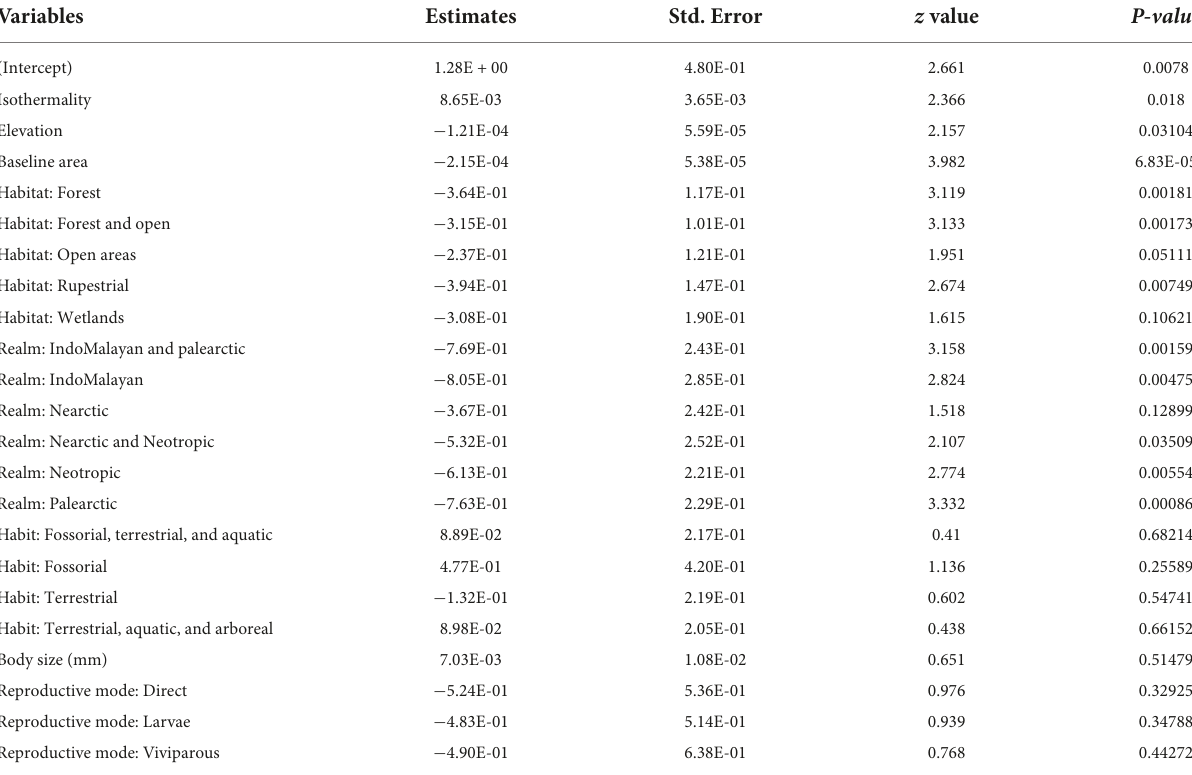
TABLE 2 Model-averaged coefficients based on conditional average including estimates, p-value , z value, standard error. Variables Estimates Std. Error z value